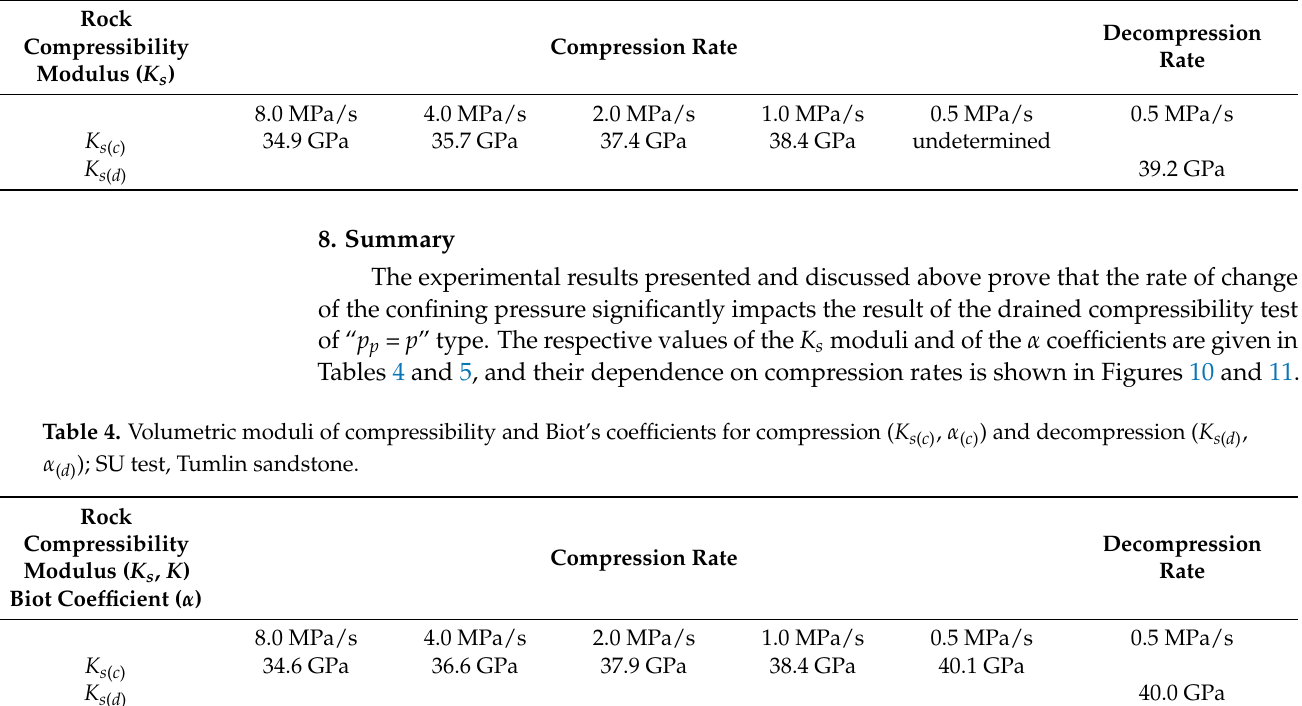
Table 3. Volumetric moduli of compressibility for compression ( K s ( c ) ) and decompression ( K s ( d ) ); FU test, Tumlin sandstone. Rock